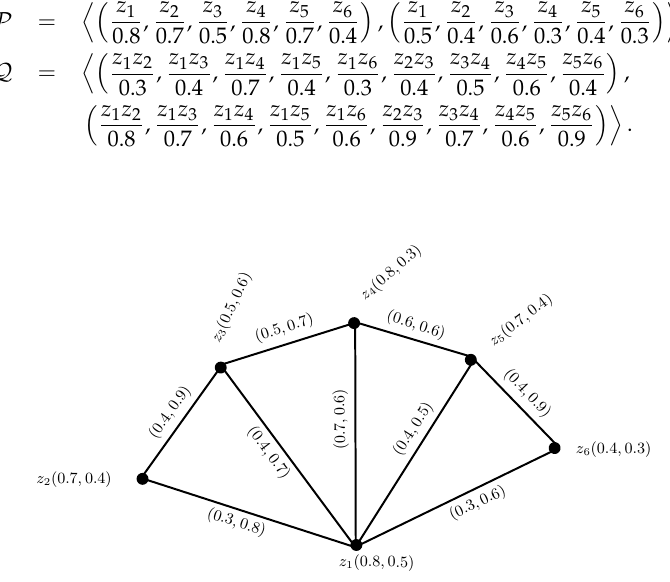
Figure 2. Pythagorean fuzzy